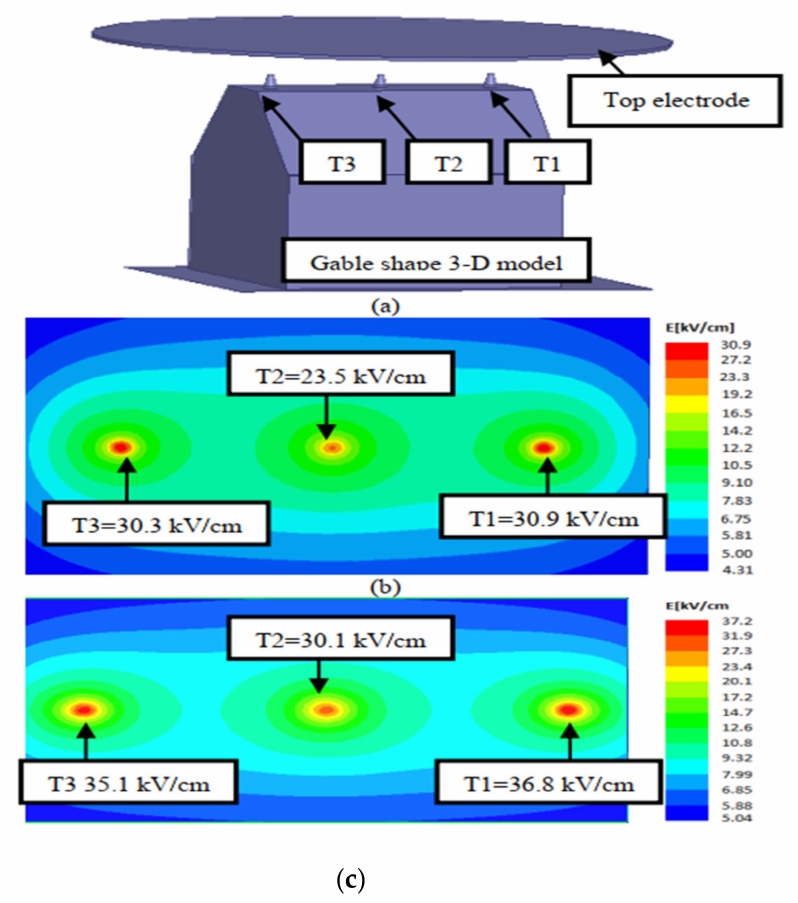
Figure 5. Probability of lightning strikes on a gable-shape scaled model: ( a ) 3D scaled gable shape, ( b ) electric field plot without upward leaders, ( c ) electric field plot with upward leaders.